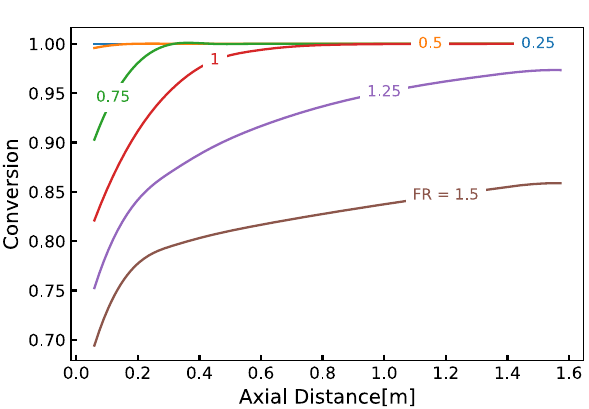
Figure 8. Fractional conversion of cerium nitrate to ceria for flow set